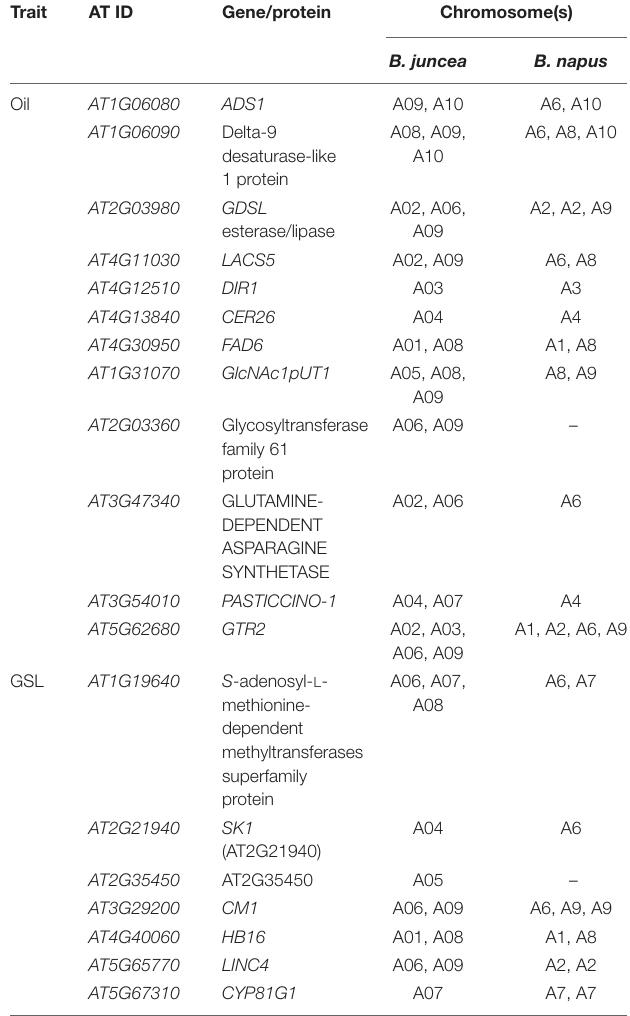
TABLE 3 | Details of identified gene copies in A